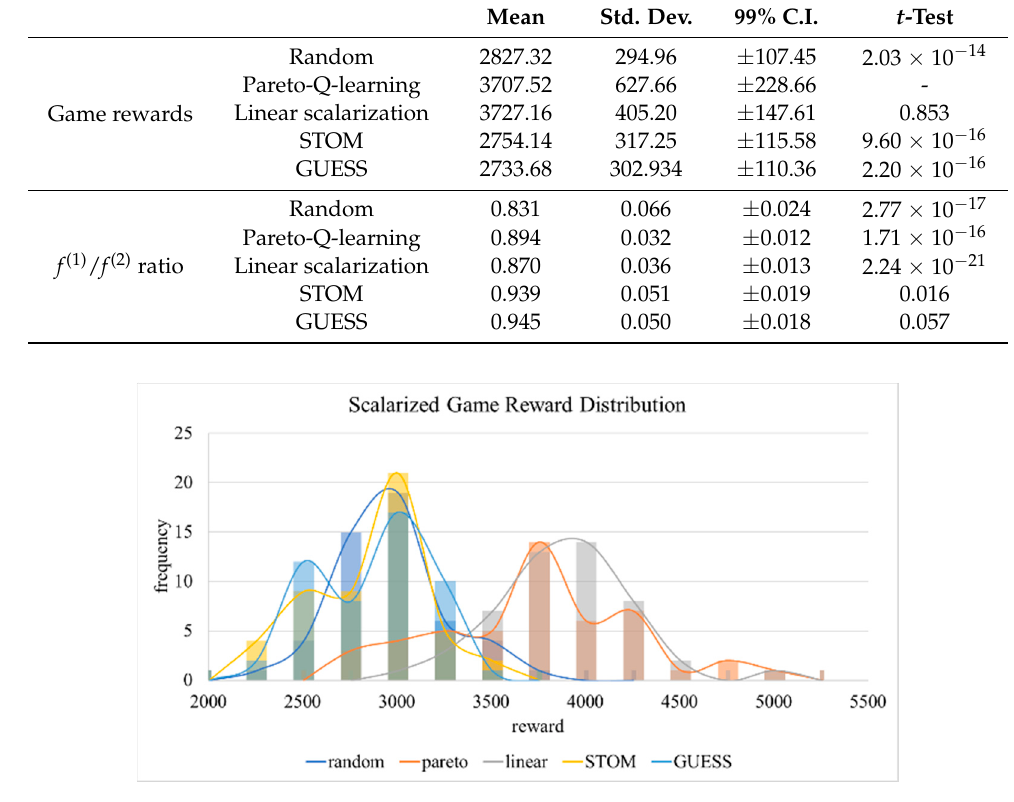
Figure 7. Distribution of scalarized game rewards.